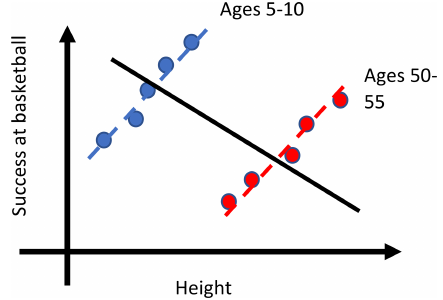
Figure A1. Demonstration of Simpson’s paradox (Simpson, 1951) with the often-quoted relationship between “success at basketball” ( y axis) and “height” ( x axis). If data are separated by age, then the expected positive relationship emerges. If data are first aggre- gated, i.e., age is not taken into account, then a negative relation- ship emerges. The analogy to the current work is that aggregat- ing blue points and red points separately and then fitting (as in the L3 methodology) may explain negative S o